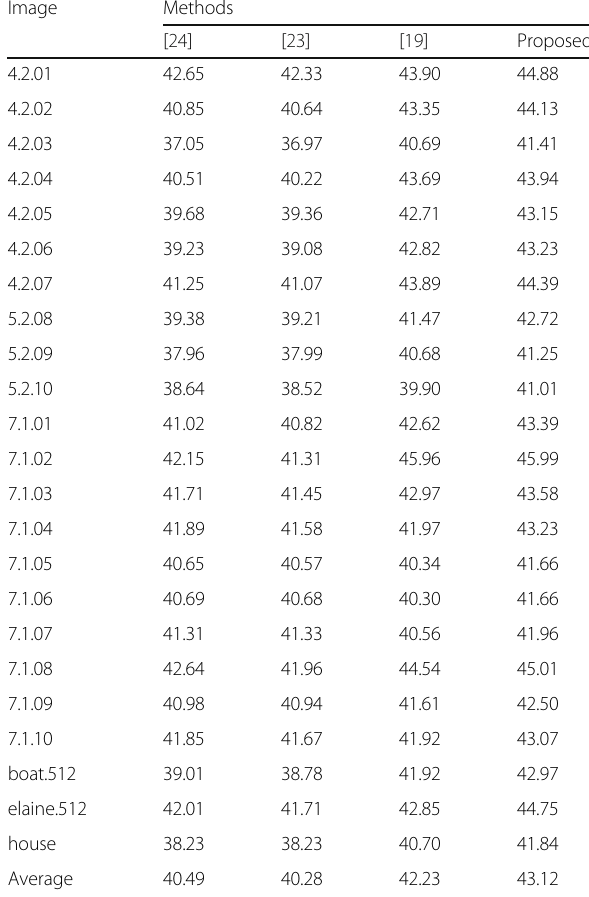
Table 3 Comparison in terms of PSNR (dB) on USC-SIPI 23 images with payload size of 10,000